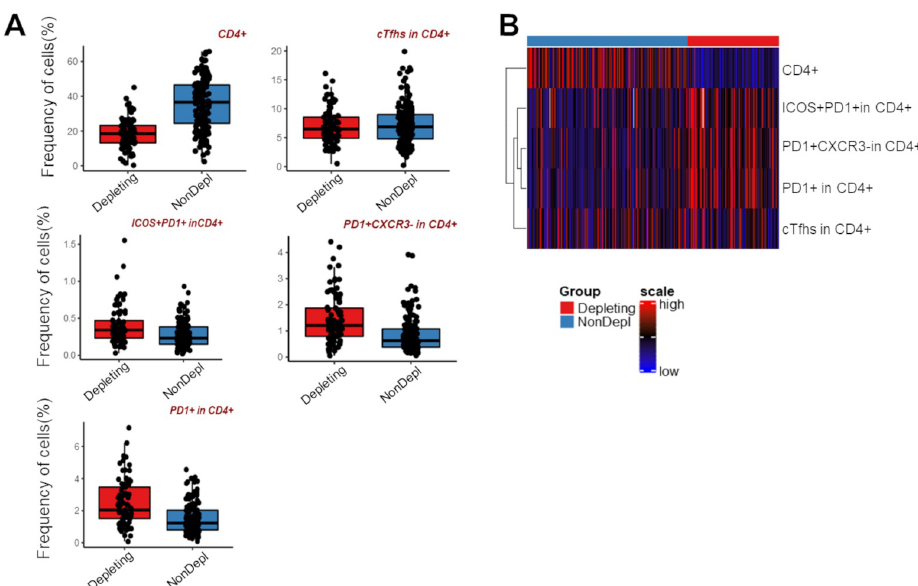
Fig 3. Cytometric dataset analysis using FaDA. A) Whisker plots of patients receiving ATG-depleting induction treatment (Depleting; n = 87) and basiliximab nondepleting treatment (n = 145) or the absence of induction therapy (n = 5) (NonDepl) on the frequency of CD4 + cells, total cTfh + and cTfh subsets, namely CXCR5 + PD1 + , CXCR5 + PD1 + ICOS + and CXCR5 + PD1 + CXCR3 - , at one-year post-transplantation. B) Heatmap graph presenting a visual summary of the flow cytometry